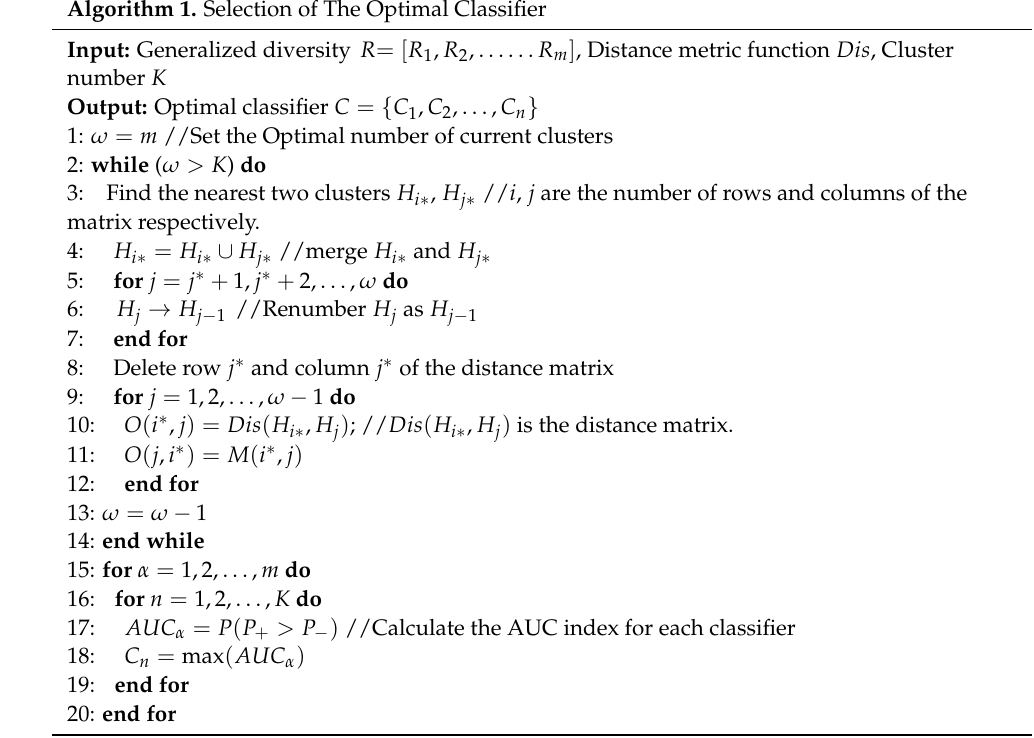
Algorithm 1. Selection of The Optimal Algorithm 1 Selection of The Optimal Classifier